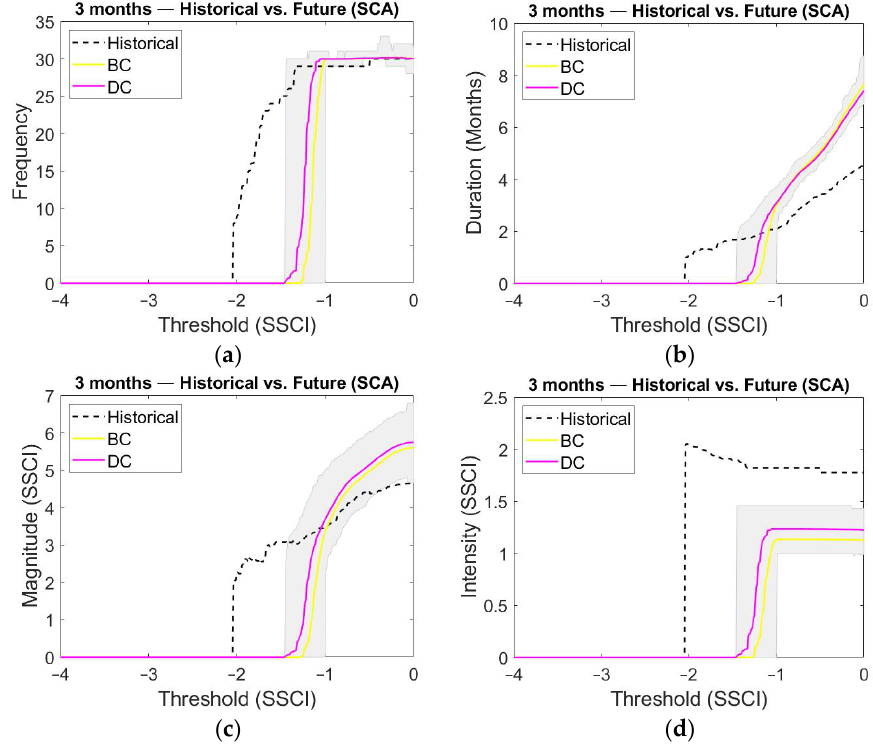
Figure 10. Historical and future hydrological drought ( a ) frequency; ( b ) mean duration; ( c ) mean magnitude; ( d ) mean intensity derived from SSCI for the 3 months temporal-aggregation scale.